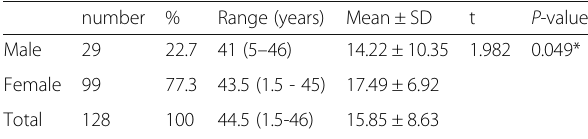
Table 1 Age comparison between male and female cases of domestic violence in south region, Jordan ( n =